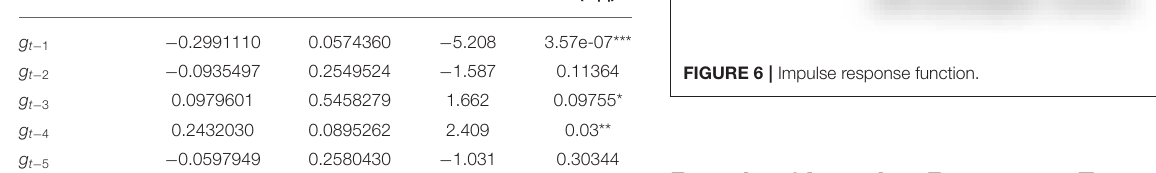
TABLE 5 | VAR Model Estimates for G-price with dollar exchange rate during Non-COVID-19 period. Co-efficient Estimate